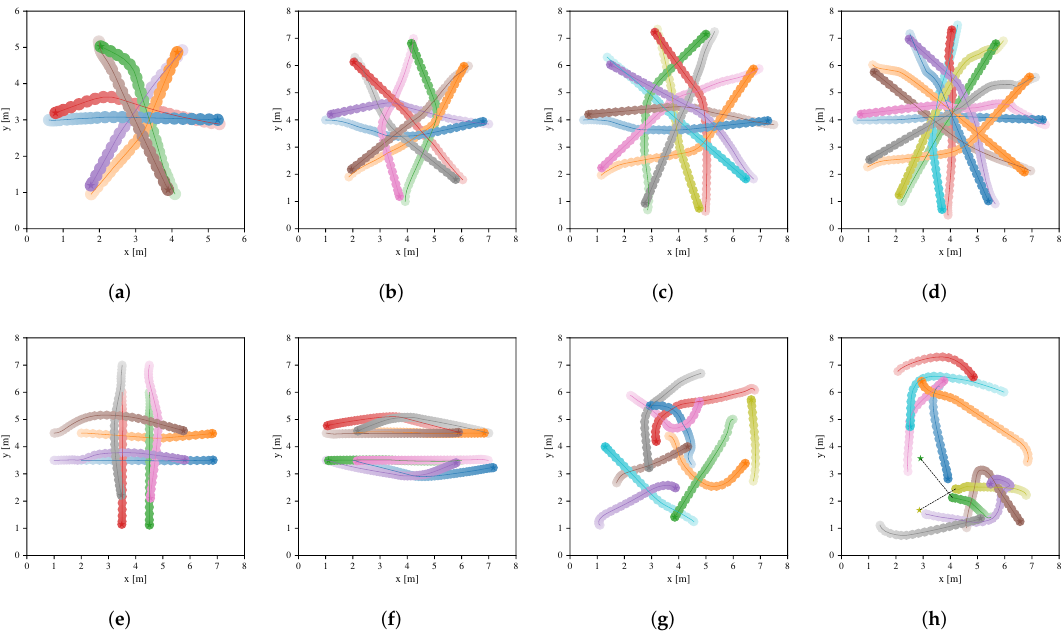
Figure 8. Trajectories of robots executing NH-ORCA policy in environments of the circle scenario ( a – d ), cross scenario ( e ), swap scenario ( f ) and new random scenario ( g , h ), respectively. The trajectories of different robots are distinguished by different colors, and color transparency is used to indicate the time state along each